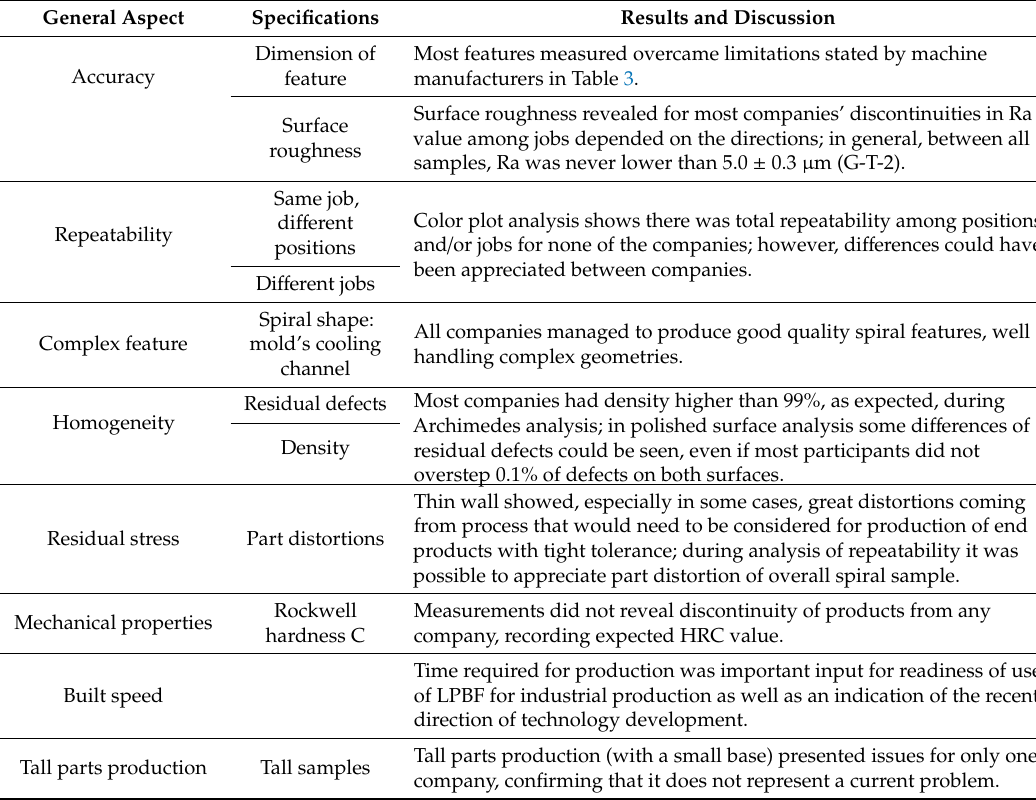
Table 13. Results overview and discussion.